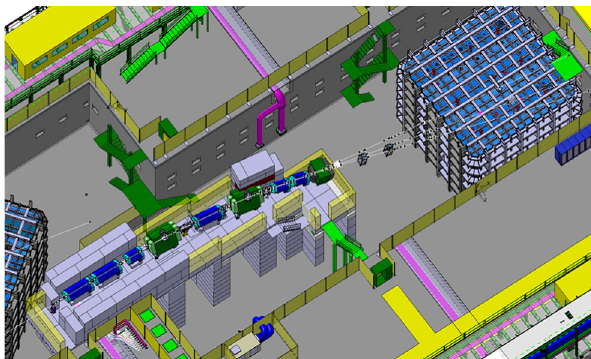
FIG. 6. 3D model layout of the H4-VLE beam line. The NP-04 cryostat is shown in the back. The tertiary beam goes from left to right and starts at the secondary target shown at the start of the concrete platform. (Courtesy: V. Clerc and S.